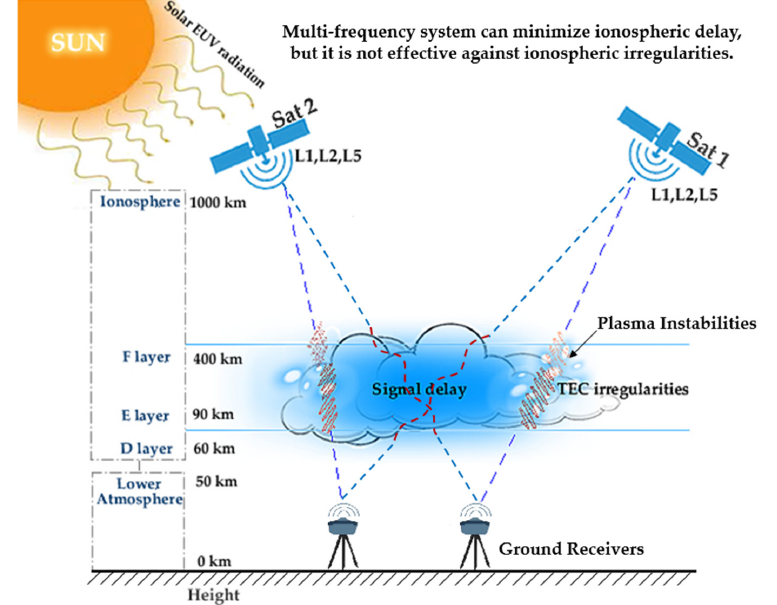
Figure 1. The difference between ionospheric delay (due to TEC) and ionospheric scintillation (due to small-scale irregularities). Ionospheric delay can be almost completely mitigated by using